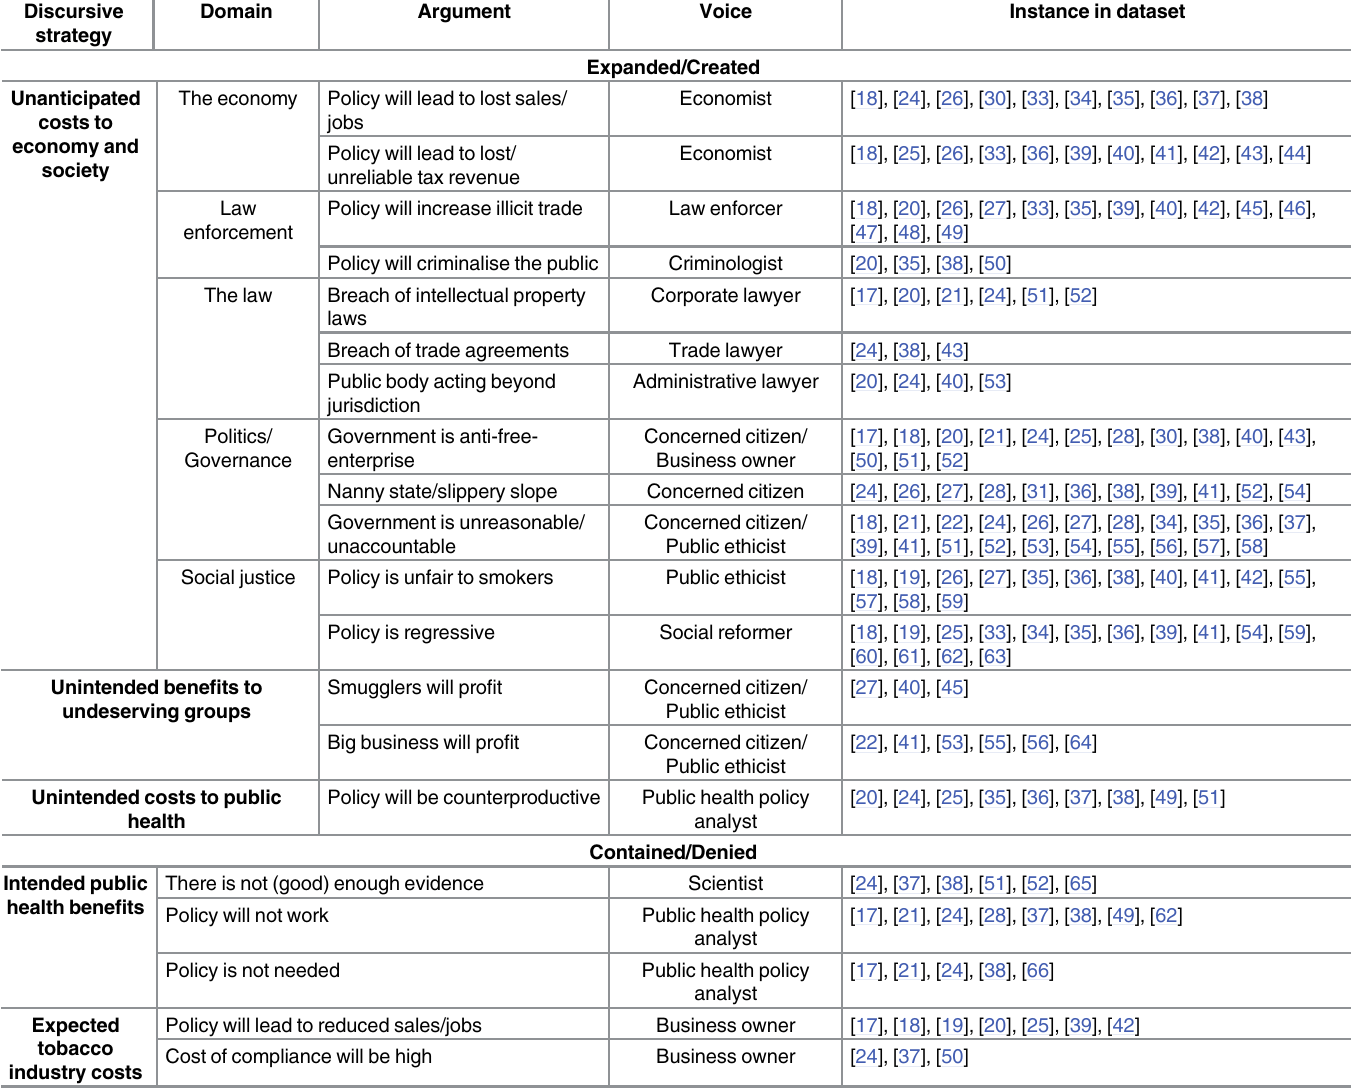
Table 3. Taxonomy of discursive strategies and arguments used to construct policy